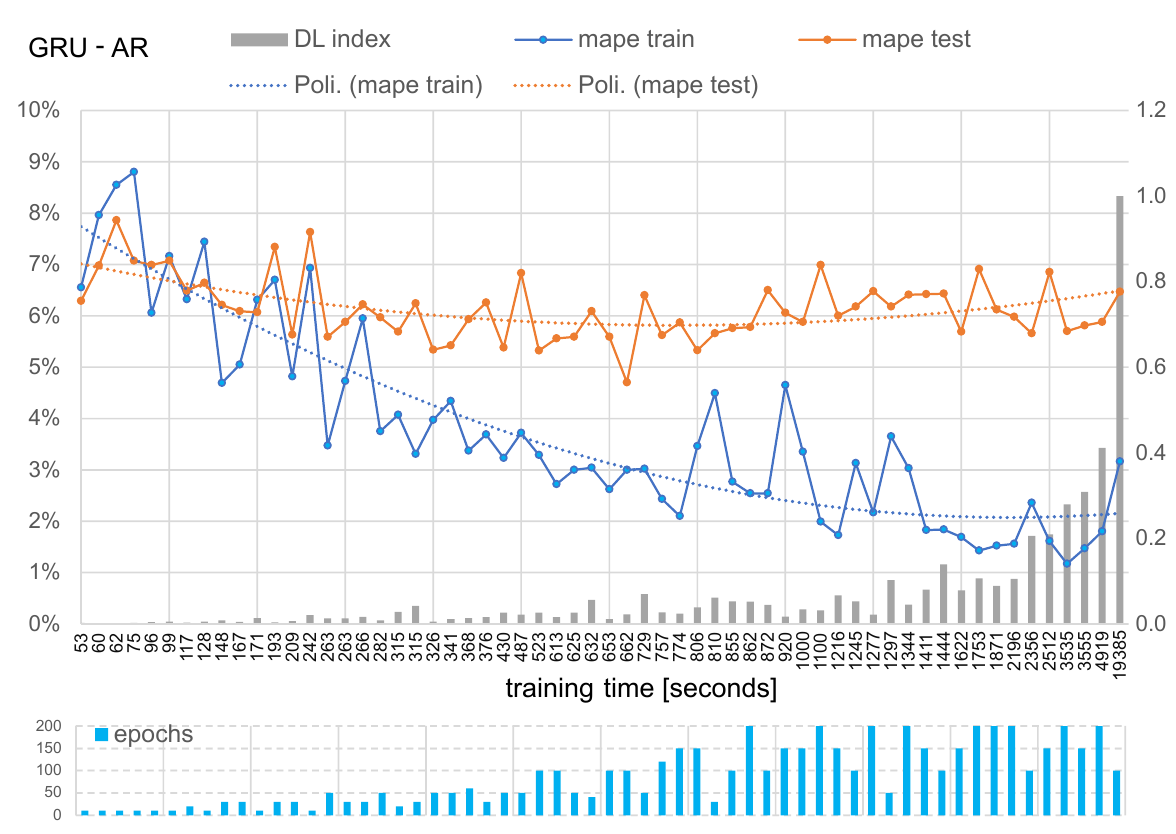
Figure 12. Comparison of the DL index with the training time, number of epochs and